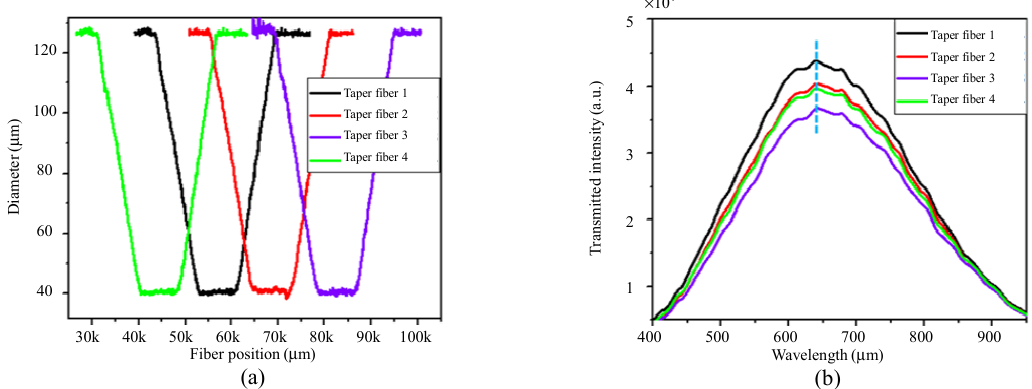
Fig. 7 Homogeneity analysis of the fabricated tapered fiber structures: (a) diameter analysis and (b) transmitted